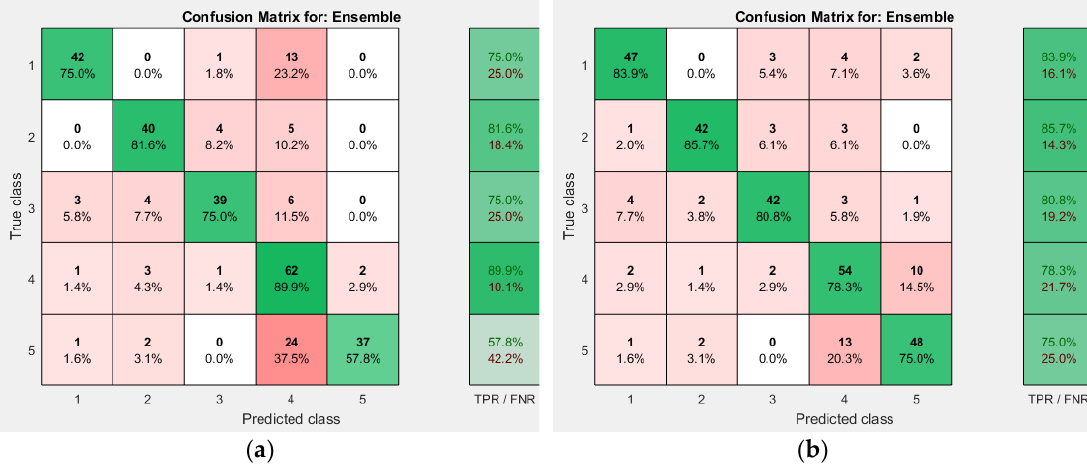
Figure 12. Ensemble Decision Tree Confusion Matrix. ( a ) AdaBoost; ( b ) Bag.